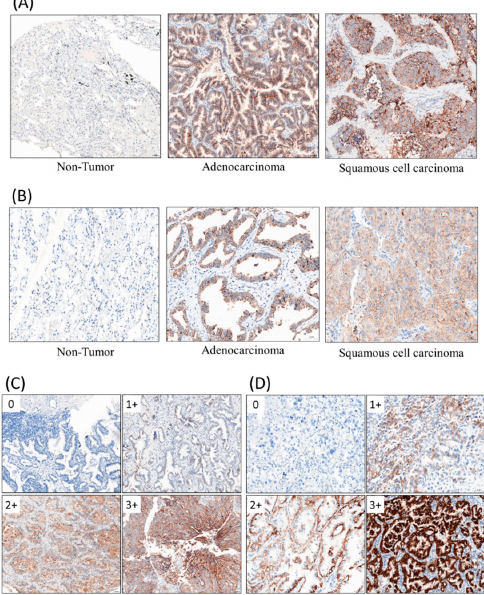
Figure 1. Immunohistochemical staining (IHC) stains with primary antibodies against coxsackievirus/adenovirus receptor (CAR, 1:100), desmoglein 2 (DSG2, 1:50). ( A ) CAR, ( B ) DSG2, ( C ) immuno-intensity of CAR, ( D ) immuno-intensity of DSG2. In order to evaluate the immunostaining results objectively, we performed whole-slide scanning with computer counting. The slides were scanned with a slide scanner (Panoramic DESK